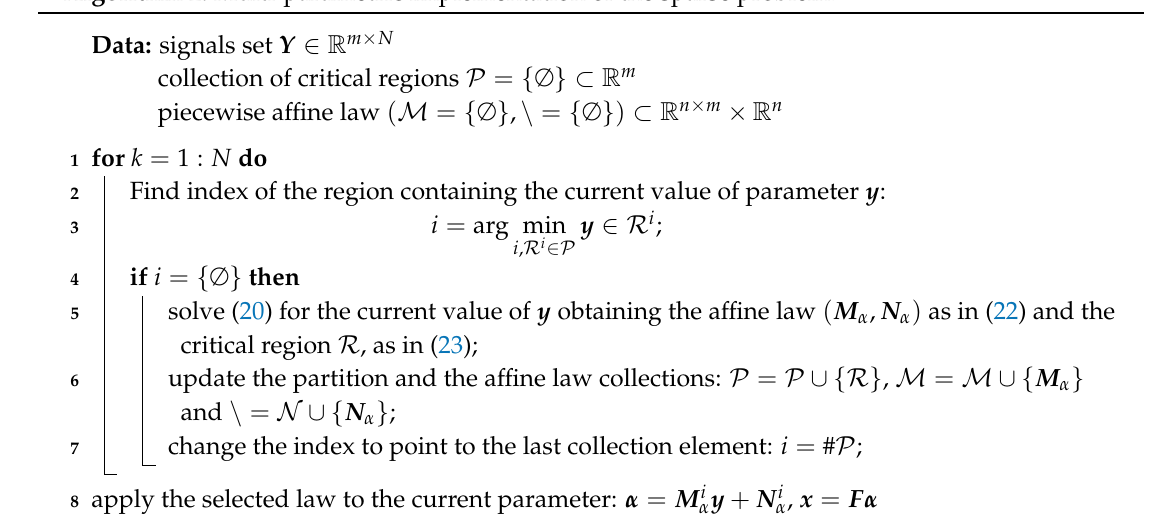
Algorithm 2: Multi-parametric implementation of the sparse